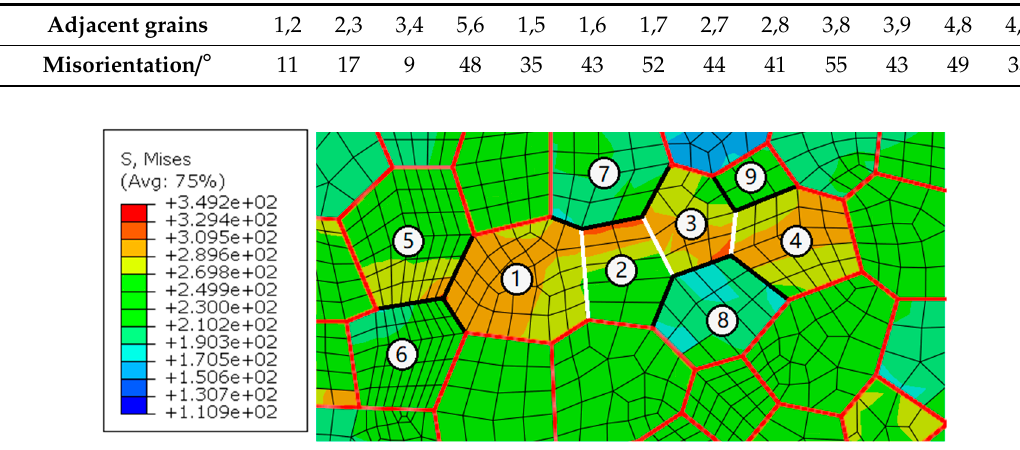
Figure 13. Stress transfer through low-angle misorientation grain boundaries, MPa. Table 3. Misorientations of adjacent grains in Figure 13.